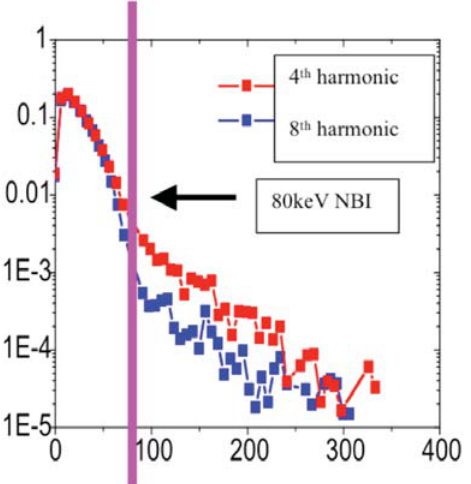
Figure 17. Energetic ion distribution accelerated by high harmonic on ion cyclotron RF (ICRF)